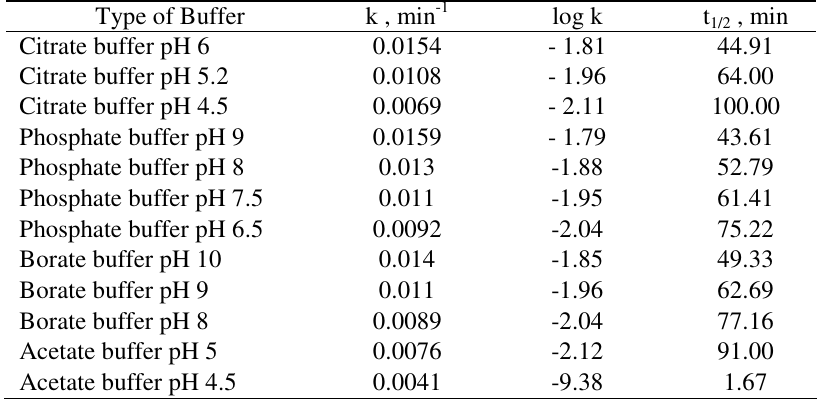
Table 5. Comparison between the different buffer systems on the degradation of nicardipine (40 µg/mL) at 100 0